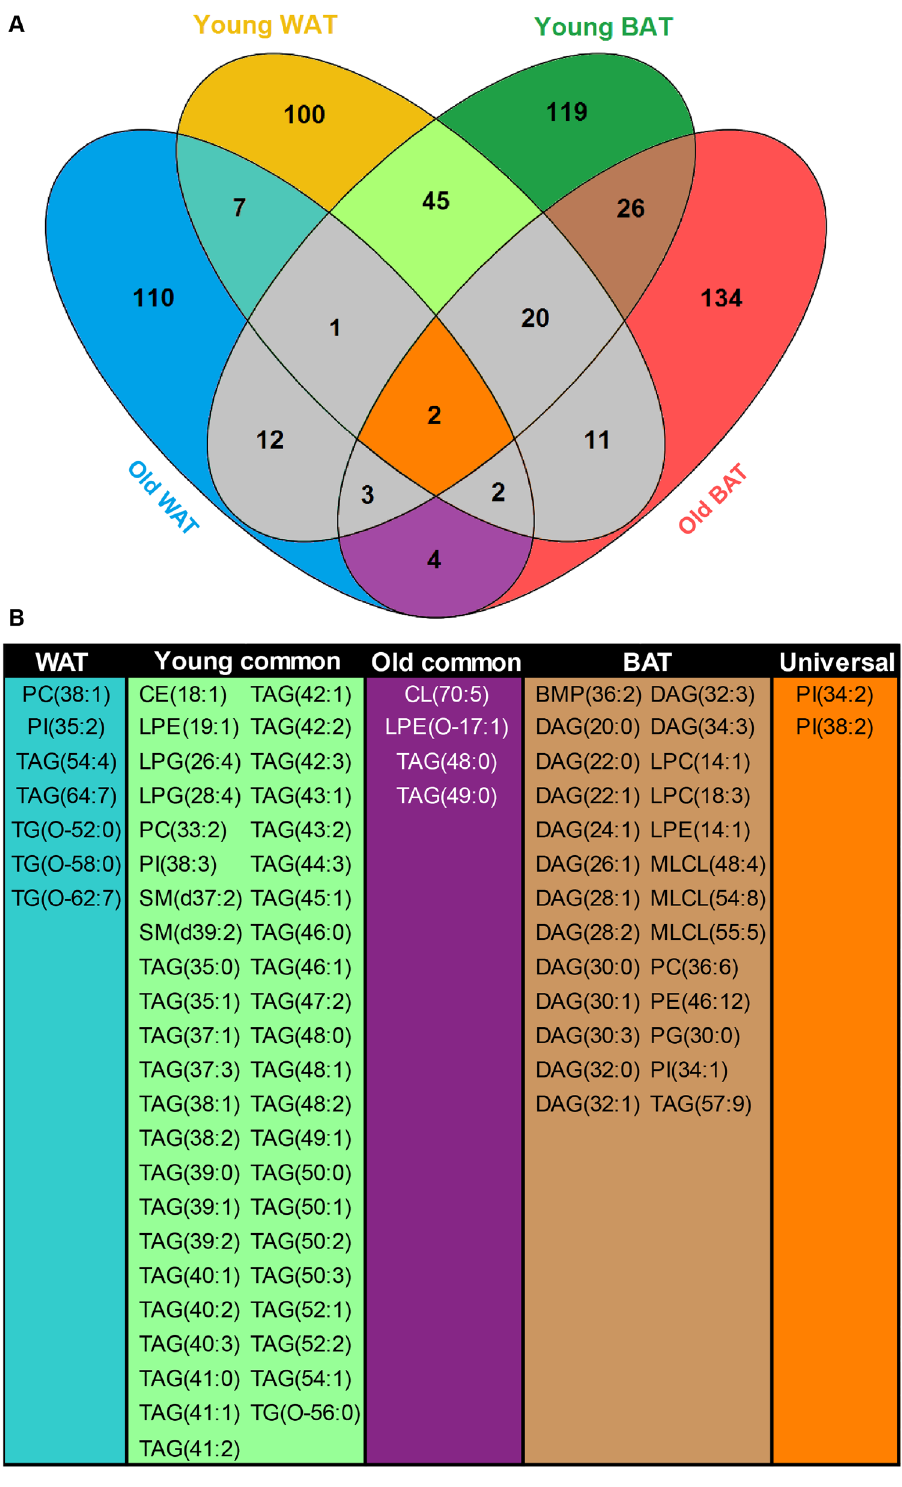
Figure 6. Overlap of rhythmic lipids in WAT and BAT upon aging. ( A ) Venn diagram depicts the number of unique and shared rhythmic lipid species of young and old WAT and BAT. The interesting areas of overlap and the number unique lipids are depicted in color. ( B ) Individual lipids species that are rhythmic in young and old WAT(WAT); in young WAT and BAT (Young common); in old WAT and BAT (Old common); in young and old BAT (BAT) and in all groups (Universal) as depicted in Venn diagram. Venn diagram was created in Venny (v2.1.0; https ://bioin fogp.cnb.csic.es/tools /venny /). Figure layout was prepared in Adobe Illustrator CS6 (v16.0.3; https ://www.adobe